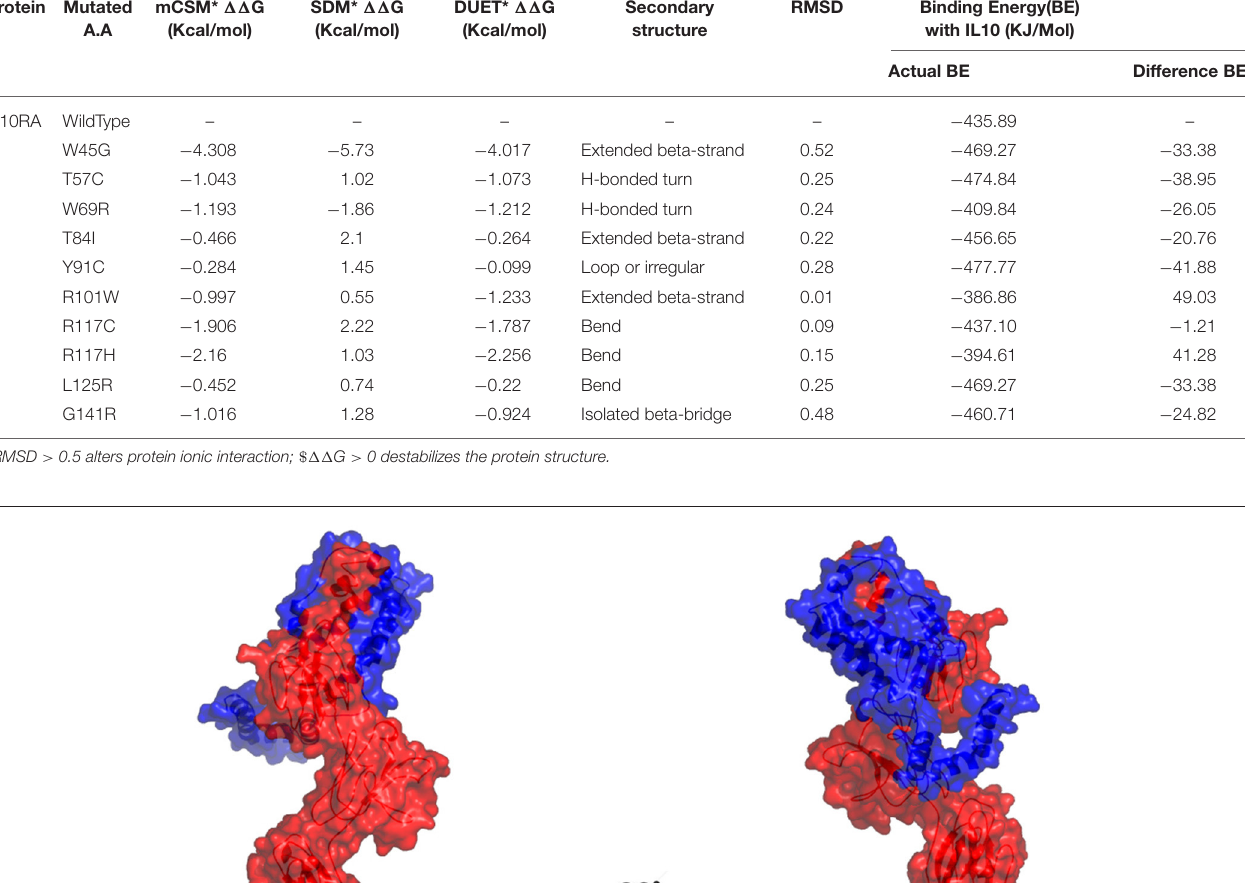
TABLE 3 | Structural stability prediction scores, secondary structural features and molecular docking analysis of IL10RA models. Protein Mutated A.A